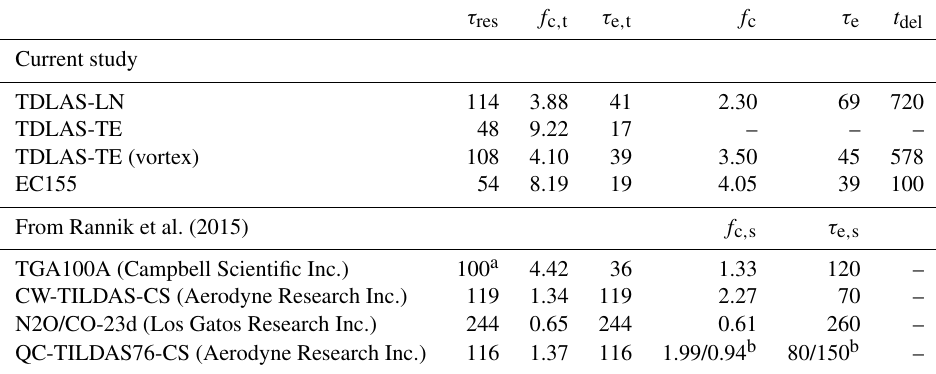
Figure 2. Daily precipitation and temperature for 2015 and 2016. Rain values (mm) are the total rainfall per day, and snow values (cm) are the depth of snow present. Table 2. Analyzer frequency-response characteristics from this study and that of Rannik et al. (2015). Residence times ( τ res ) were calculated from values given in Table 1. f c , t is the theoretical best-case cutoff frequency, assuming no mixing for the single-pass sample cells and complete mixing for the multi-pass sample cells, and τ e , t is the corresponding effective time constant. f c and τ e are results from the impulse response test. Results ( τ e , s and f c , s ) from Rannik et al. (2015) were derived from cospectral analyses. The tube delays t del are the measured total delay minus the processing delay. Time constants and t del are in units of milliseconds and cutoff frequencies are in